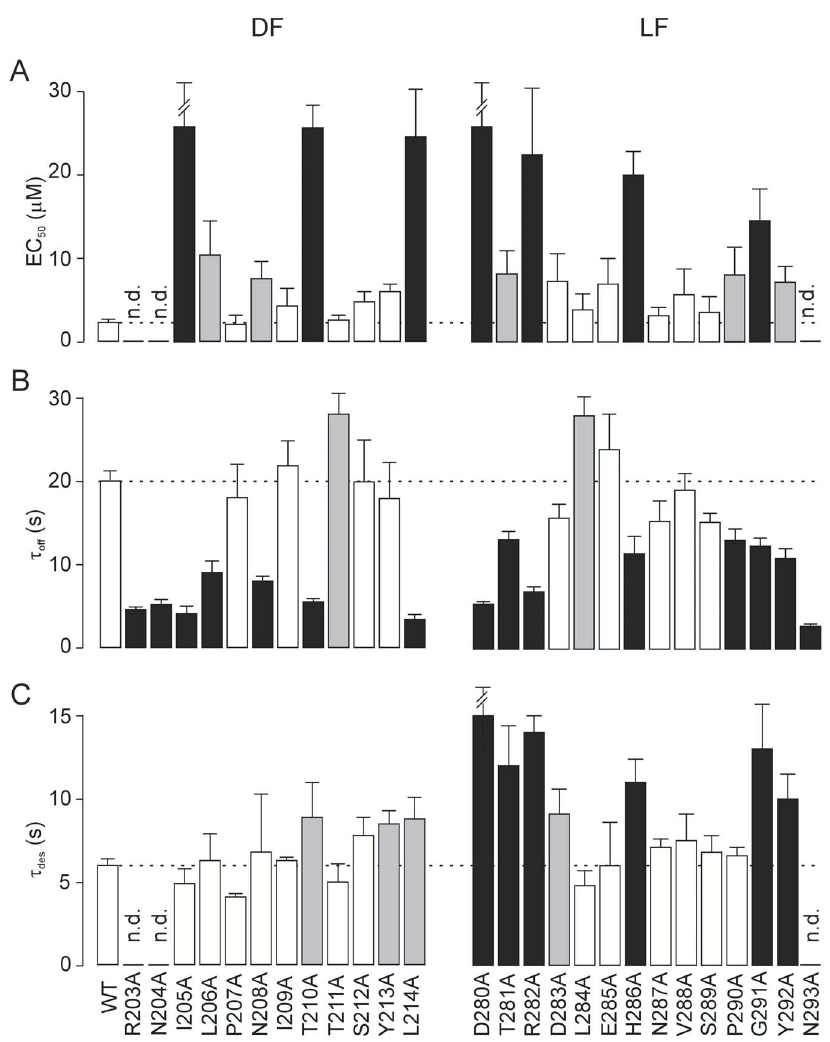
Figure 2. Characterization of rP2X4R–DF and -LF residue mutants. Effect of alanine substitutions on the potency of ATP (A), deactivation (B), and desensitization (C) kinetics. Summary histograms show the concentration of ATP producing a half-maximal current (EC 50 ), deactivation time constants ( t off ) were estimated by the monoexponential fit of the decay of current in response to 2 s of stimulation with 1–3 m M ATP after 4–6 min of preincubation with 3 m M IVM and desensitization time constants ( t des ) were derived from the biexponential fit of the response to 60 s of stimulation with 100 m M ATP for WT and alanine mutants of the dorsal fin (DF) and the left flipper (LF) domains. Values shown (and also given in Table S1) are the mean 6 SEM of 21–63 measurements per mutant and 267 measurements for the WT. Significant differences between the WT and the mutant receptors are shown in gray (p , 0.05) or black (p , 0.01) columns. Horizontal dotted lines illustrate the values for WT receptor and n.d. indicates that the value could not be